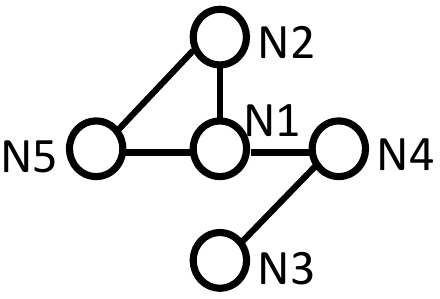
Figure 7. Network topology. Note that this topology is used as an example to show the efficacy of the consensus algorithm. The topology can be time-varying and unknown.